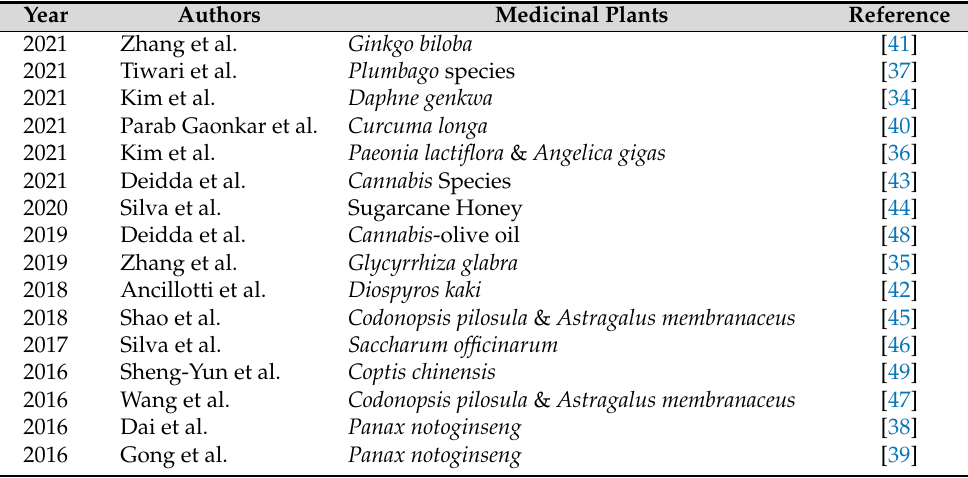
Table 2. The summary of Table S1 “Applications of AQbD to the development of analytical procedures for plant sources, published from 2016 to 2021”.